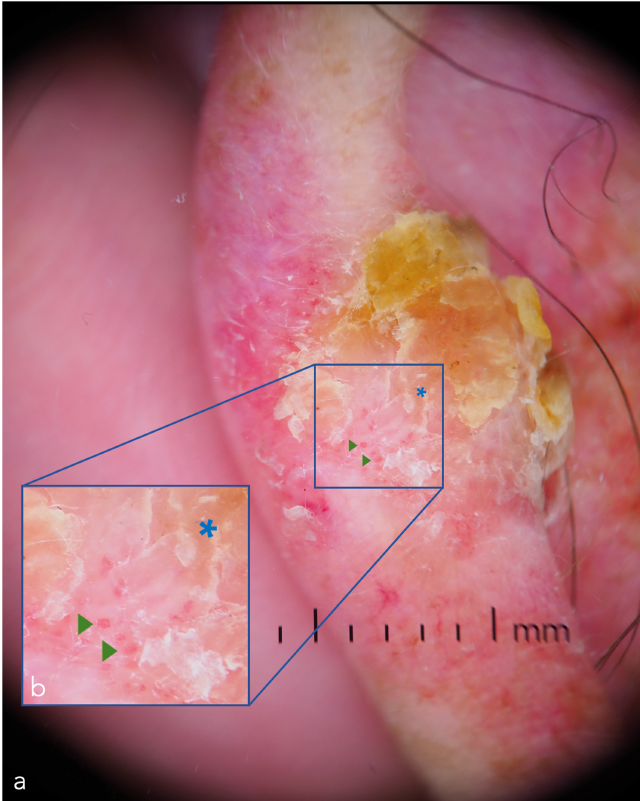
Figure 5. Dermoscopic image of a squamous cell carcinoma of the helix. The presence of yellow- white, amorphous areas of keratin (blue asterisk) and hairpin vessels (green triangles) help the clinician in the diagnosis of this squamous cell carcinoma: ( a ) Dermoscopic image; ( b ) Magnification of the vascular component.